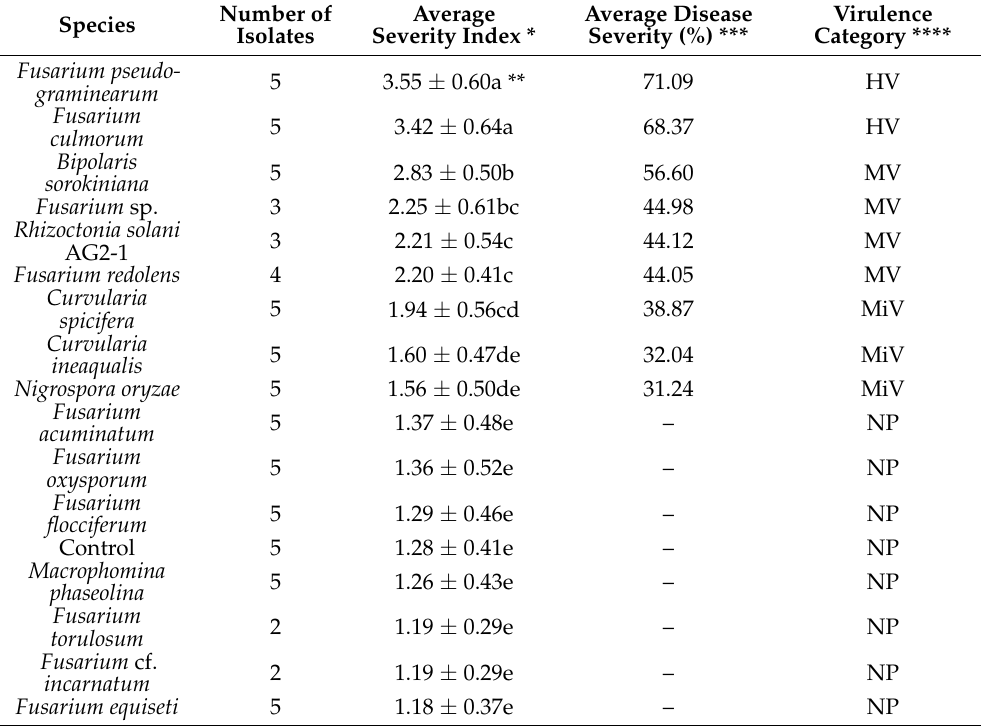
Table 3. The pathogenicity of the fungal species identified in the present